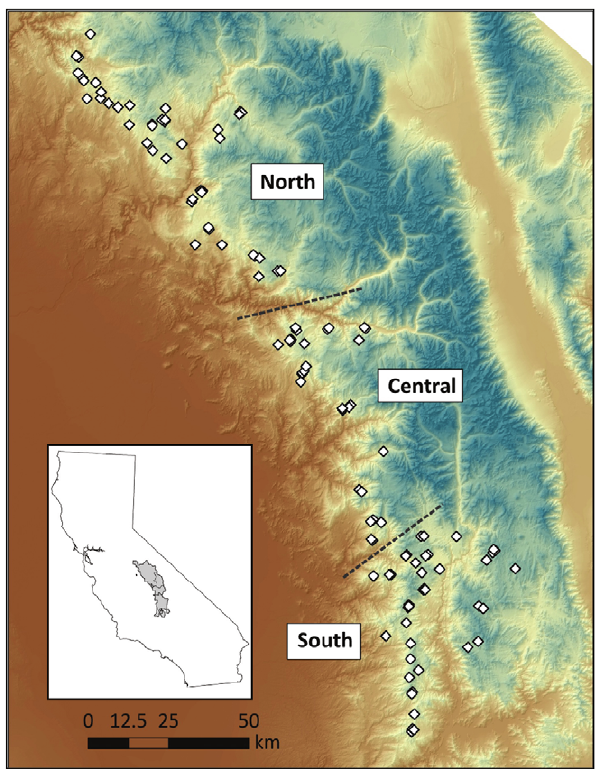
Figure 3. Population subdivision in the southern Sierra Nevada. Approximate location of population subdivisions used in bottleneck analyses within the contemporary southern Sierra Nevada.